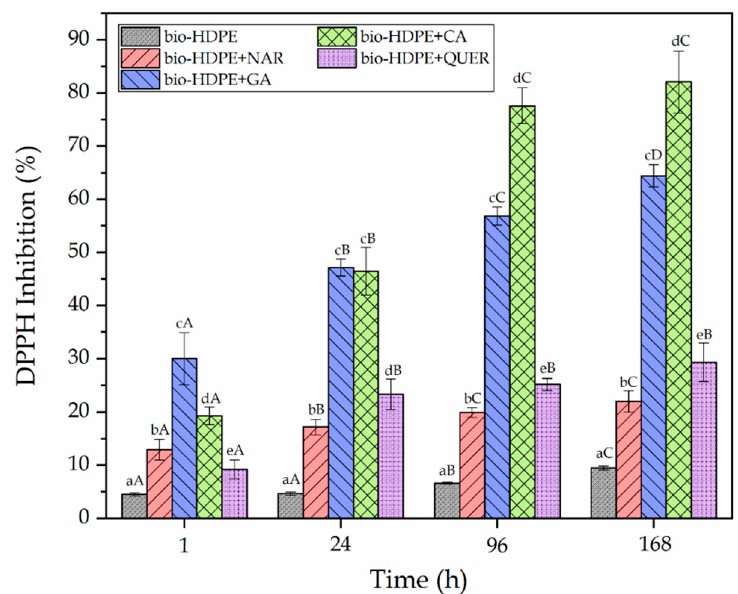
Figure 10. Percentage of 2,2-diphenyl-1-picrylhydrazyl radical (DPPH) inhibition of the thermo- compressed bio-based high-density polyethylene (bio-HDPE) films containing naringin (NAR), gallic acid (GA), caffeic acid (CA), and quercetin (QUER). a–e Different letters in the same period for different samples indicate a significant difference ( p < 0.05). A–D Different letters for the same sample in different periods indicate a significant difference ( p < 0.05).